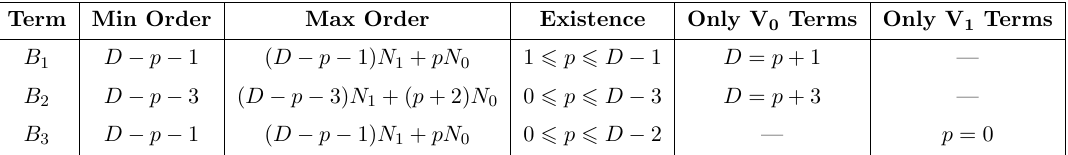
Table 2 . This table indicates the minimum and maximum order of each term, the existence conditions, that are also depicted in (cid:12)gure 1, and the conditions under which each term contains only (cid:12)elds coming from one of the